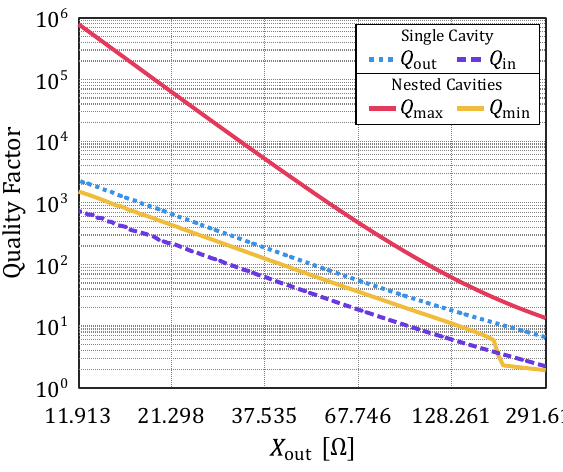
Figure 3: Quality factor of a nested cavity behaves similarly to its electric field maximum, being more resonant for lower values of the grid impedance, while the locations for maximum and minimum values are the same for the electric field maximum. Compared to the individual quality factor of the outer and the inner cavities, a nested cavity can offer a variable quality factor that can be similar to the individual cavities or become more narrowband. The drop of Q result of neighbor four-layer resonant modes that extend the band-pass